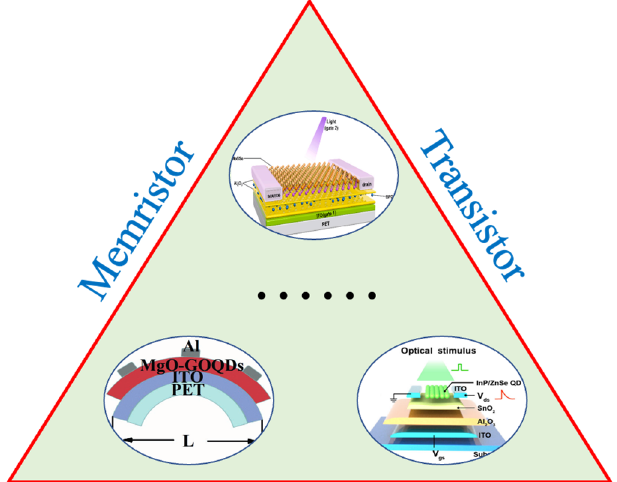
Figure 2. Representative 0D materials used in the fabrication of artificial synapses. The 0D materials can be used in both memristors and transistors incorporated with other materials [51,53,54]. Reprinted/adapted with permission from Ref. [51]. Reprinted/adapted with permission from Meng, 2021. Reprinted/adapted with permission from Ref. [53] Yu, 2021. Reprinted/adapted with permission from Ref. [54] Liang 2022.